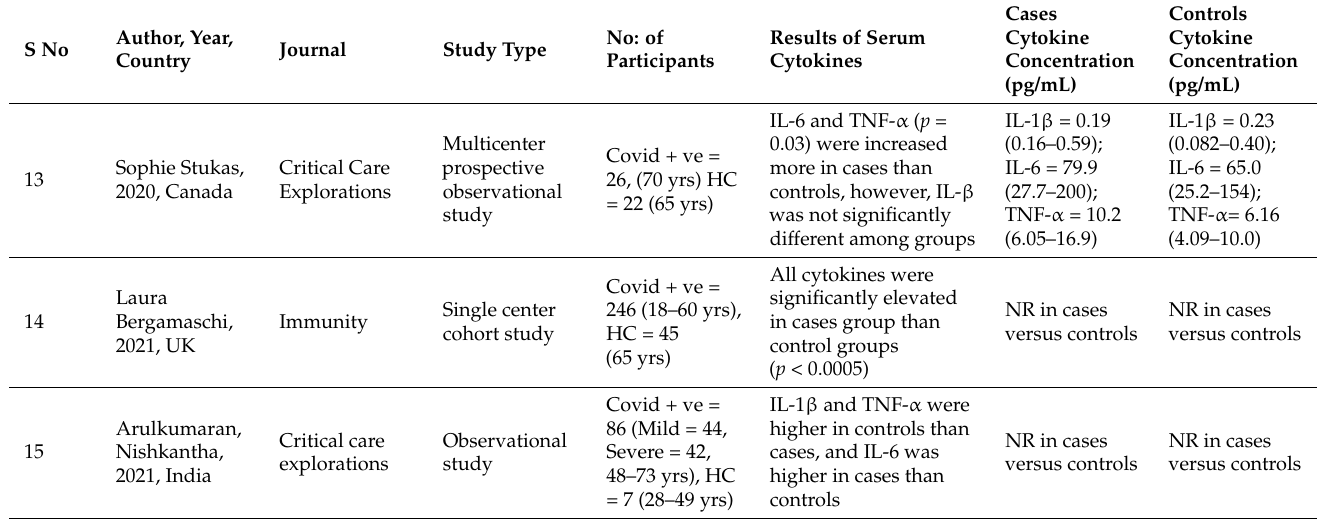
Table legends: Covid + ve = confirmed COVID-19 patients with RT-PCR. After the data analysis, serum cytokine concentration was extracted from 11 periodon- titis studies and the highest reported concentration for IL-1 β level was 114 pg/mL, whilst IL-6’s was 125.4 pg/mL, and TNF- α ’s was 202.71 pg/mL. Among COVID-19 patients, the highest reported serum concentration of IL-1 β level was 140 pg/mL, whilst IL-6’s was 249.0 pg/mL, and TNF- α ’s was 151.59 pg/mL. Overall, higher serum IL-1 β , IL-6, and TNF- α levels were reported in COVID-19 compared to periodontitis, (Figure 3c). Another group of researchers suggested that patients showing IL-6 levels above the 50th percentile (IL-6 cut-off value above 163.4 pg/mL) had a 91.7% probability of dying ( p = 0.0018),